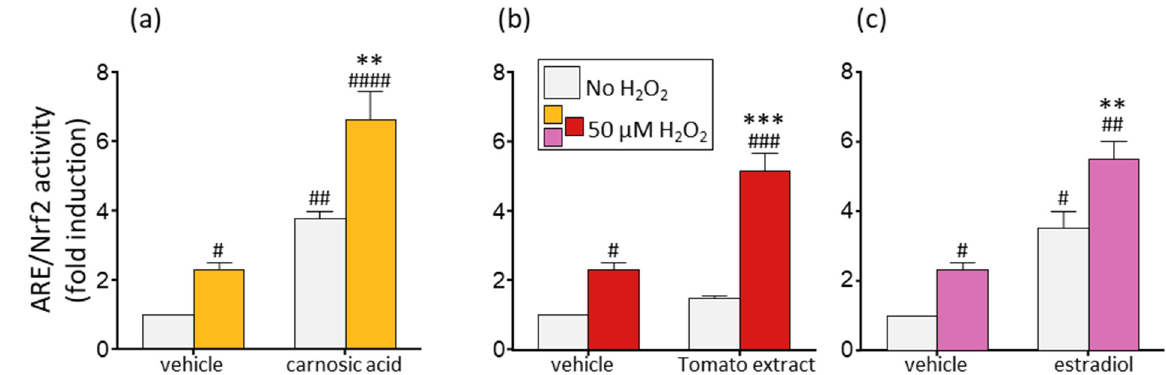
Figure 7. Activation of ARE/Nrf2 by the phytonutrients and estradiol in the presence of H 2 O 2 . Cells were seeded in 24-well plates (10 5 cells/well), and 24 h later were transfected with the ARE/Nrf2 reporter gene, and ARE/Nrf2 transcriptional activity was determined as described in Section 2.6. After transfection, cells were incubated for 16 h with ( a ) rosemary extract (5 μ M carnosic acid), ( b ) tomato extract (10 μ M lycopene), or ( c ) estradiol (10 nM), and with (dark columns) or without (light columns) H 2 O 2 . Values (fold induction) are the means ± SEM of 3–4 experiments, each performed in triplicate. # p < 0.05, ## p < 0.01, ### p < 0.001, #### p < 0.0001, significant difference between treatment and the vehicle without H 2 O 2 . ** p < 0.01, *** p < 0.001, significant difference between treatments with and without H 2 O 2 .